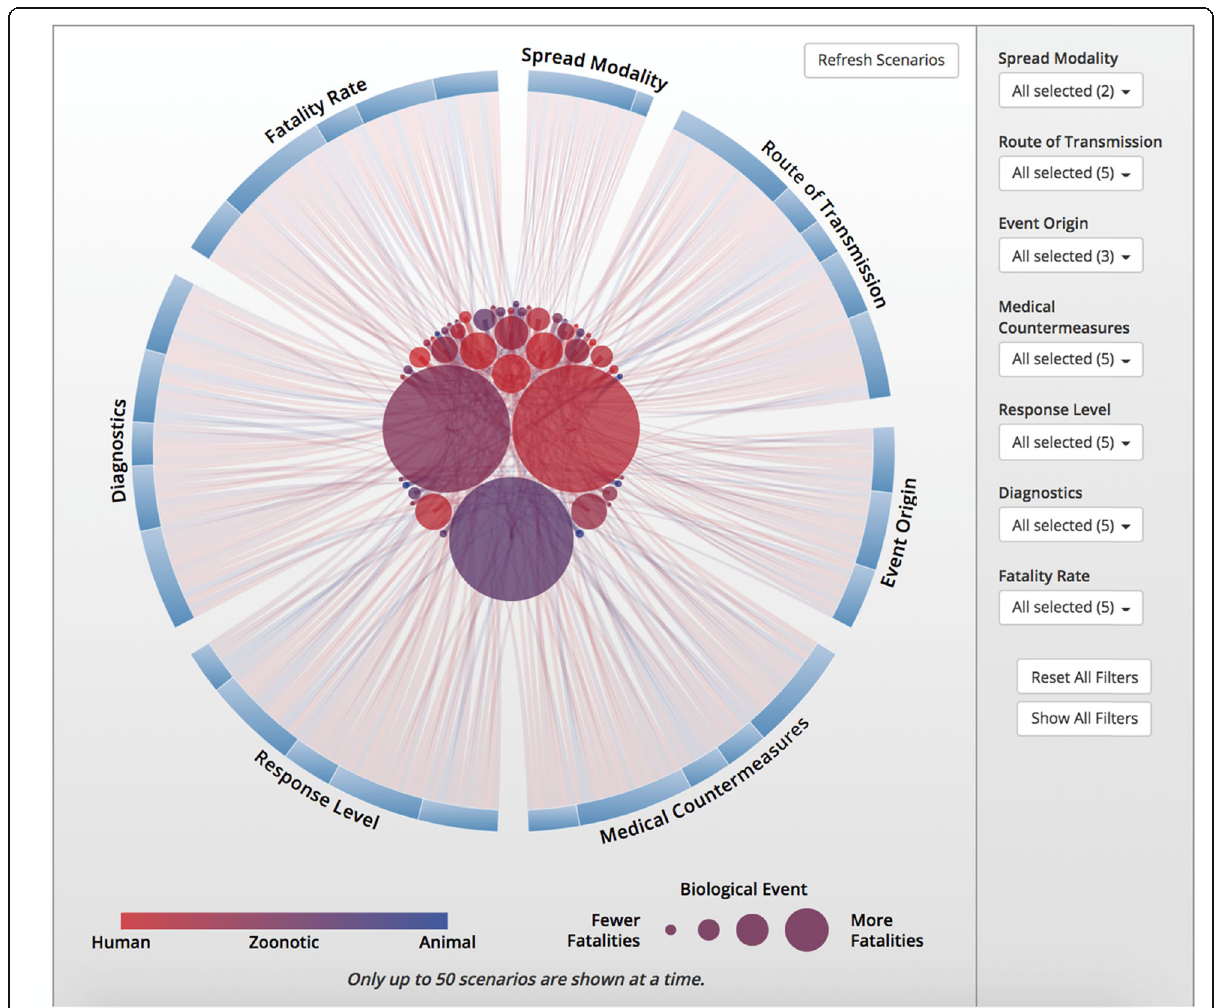
Fig. 3 Response planning must be able to adapt to an increasingly broad range of scenarios. Available at: